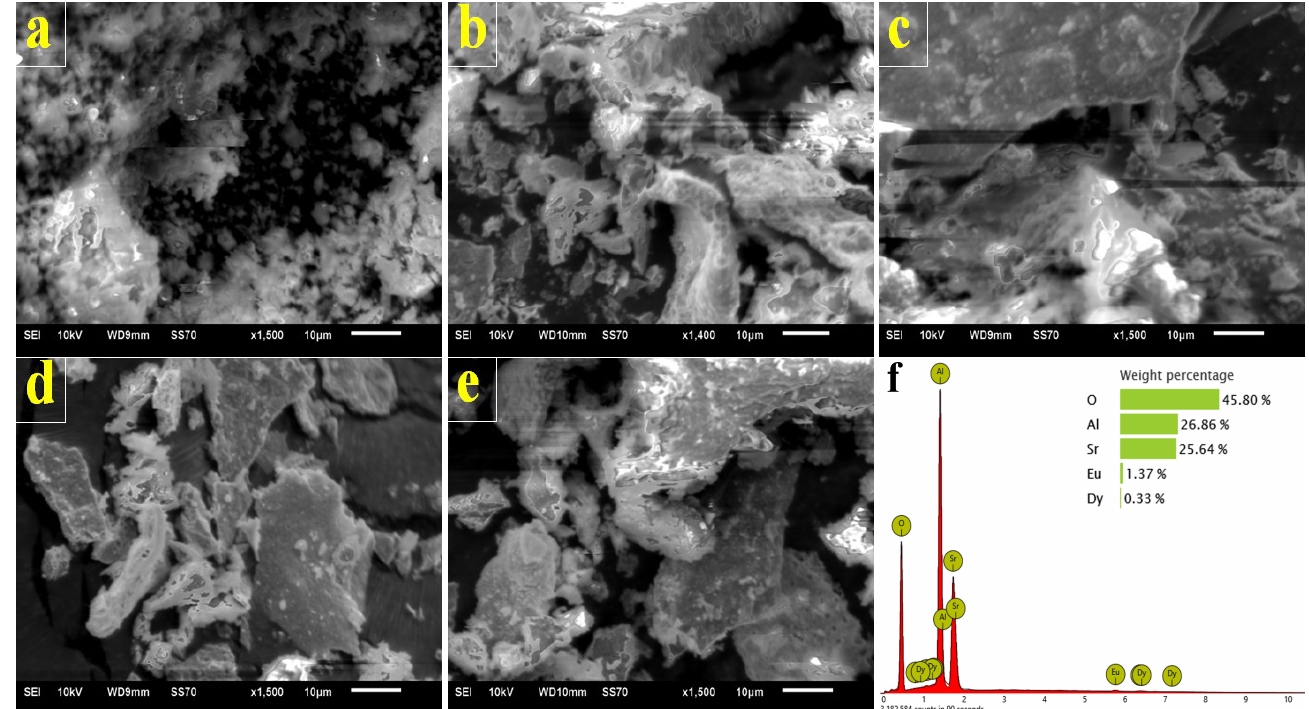
Figure 2. Scanning electron microscope (SEM) of the luminescent samples synthesized at ( a ) 500 °C, ( b ) 600 °C, ( c ) 700 °C, ( d ) 800 °C, ( e ) 900 °C, and ( f ) The energy dispersive X-ray spectroscopy (EDX) of the SrAl 2 O 4 : Eu 2+ ,Dy 3+